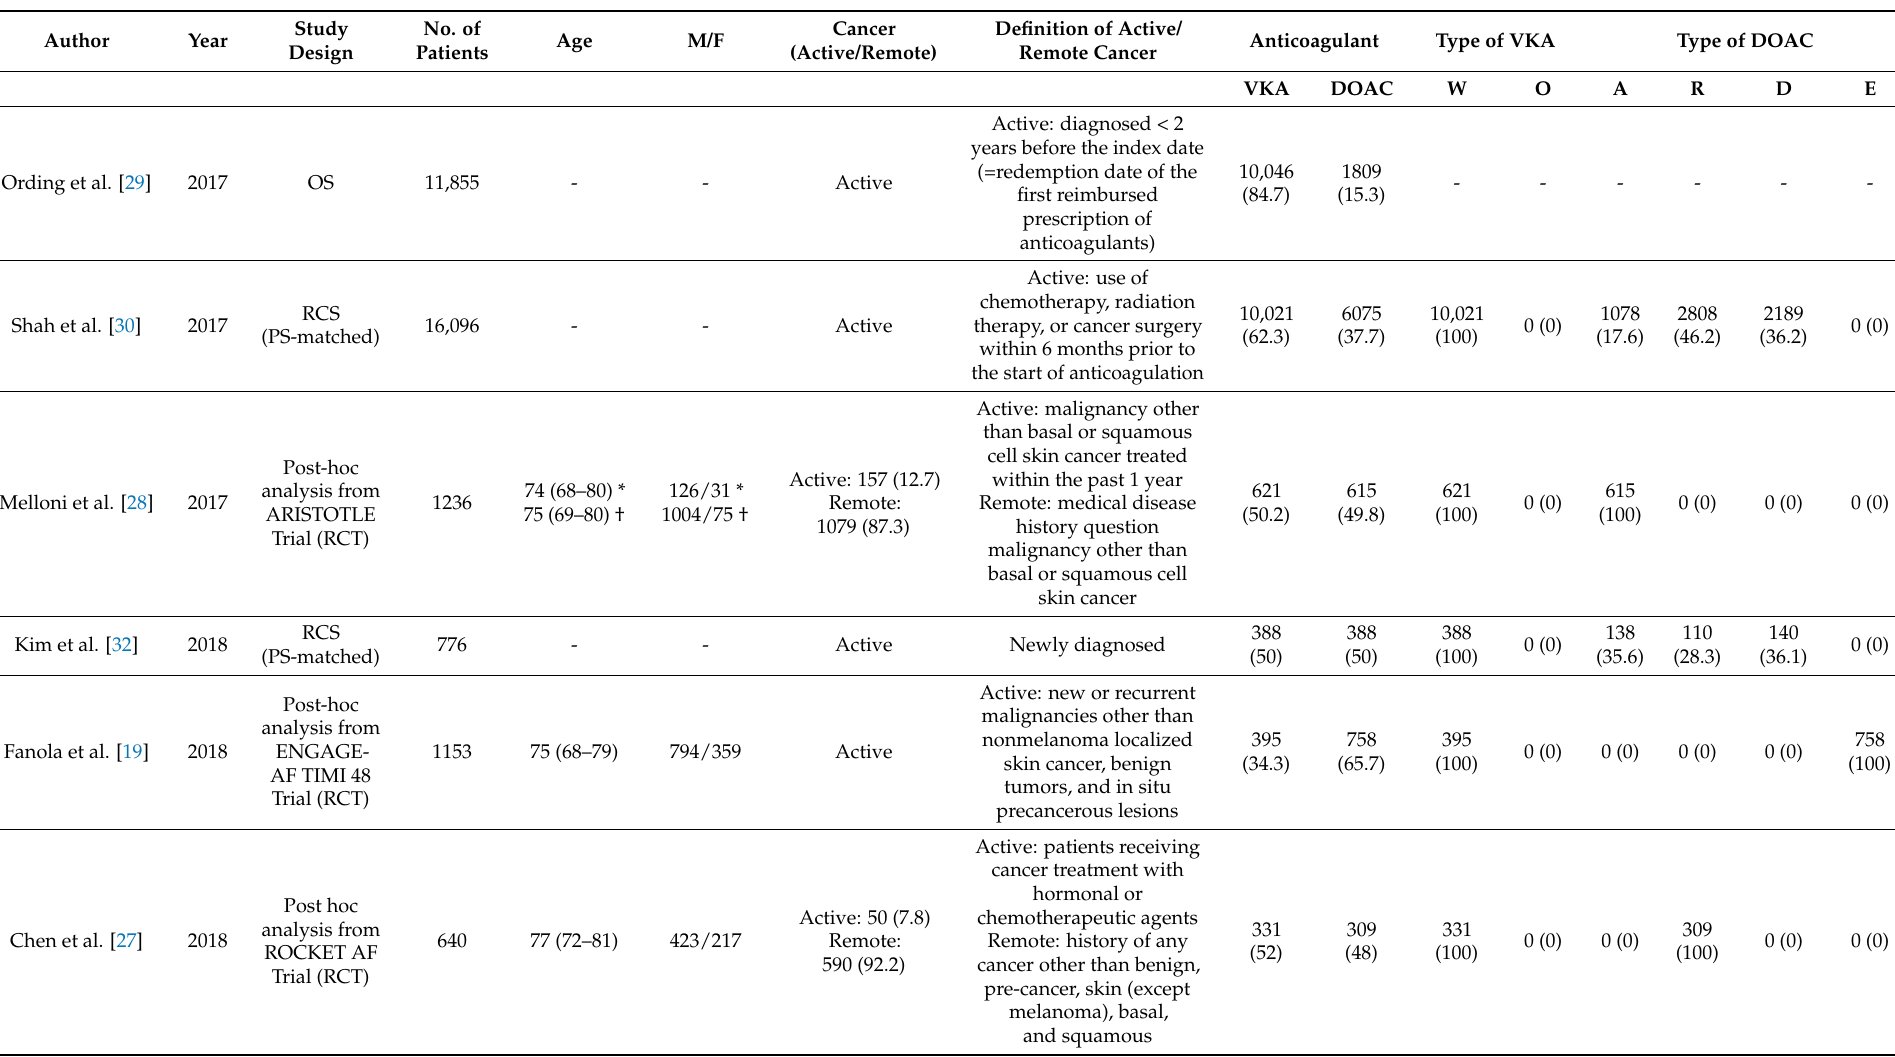
Table 1. Characteristics of the studies and overall